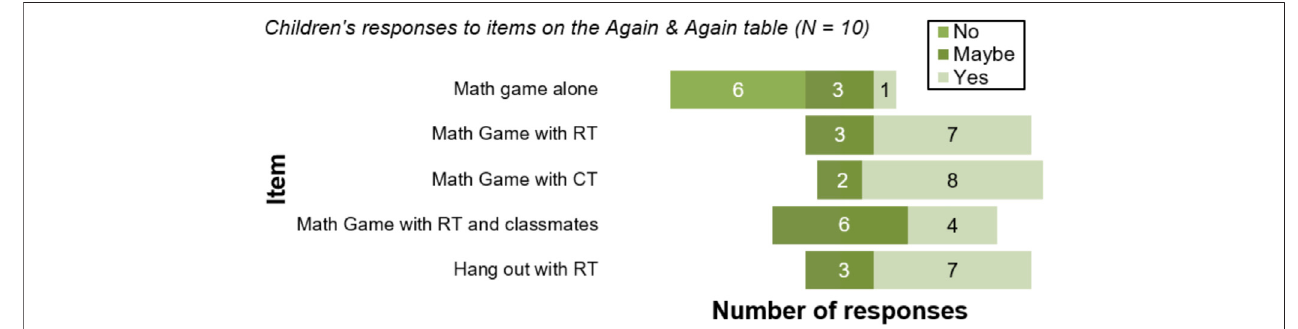
FIGURE 2 | Diverging bar chart showing frequencies of children ’ s responses to the set of questions on the A&A table.